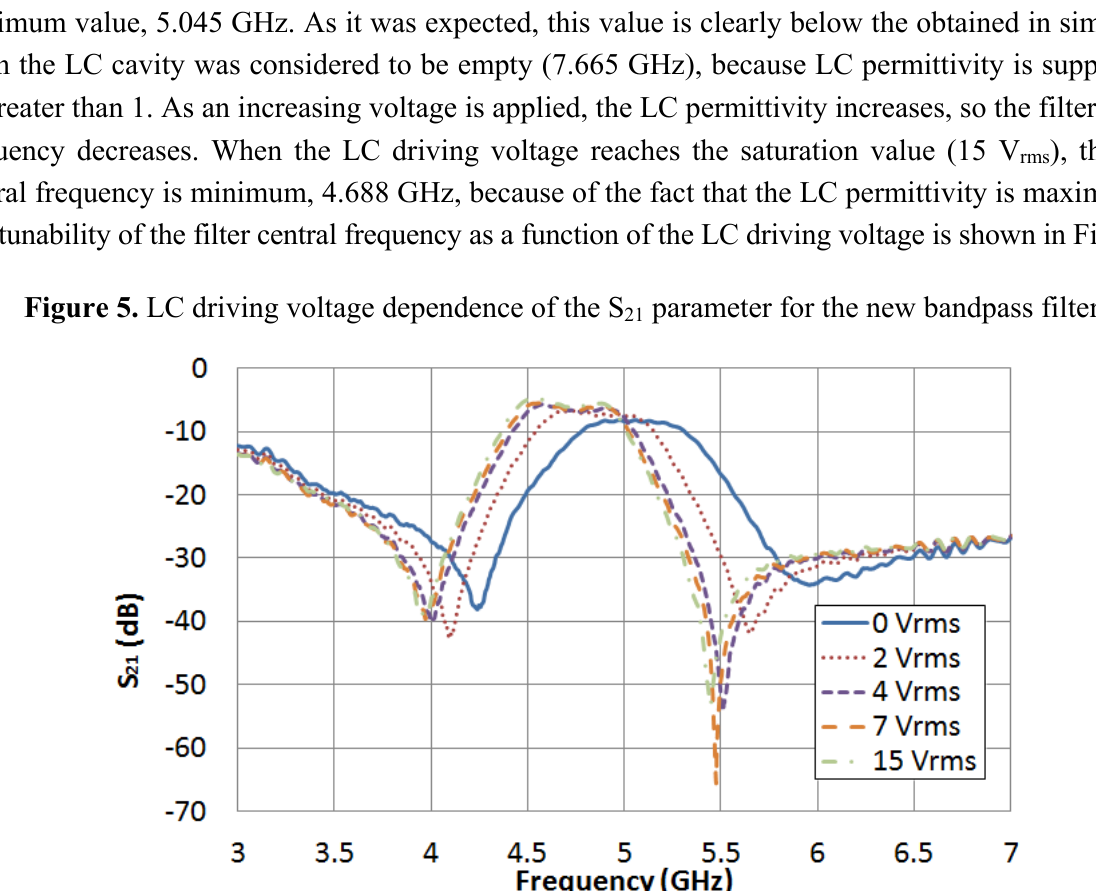
Figure 5. LC driving voltage dependence of the S